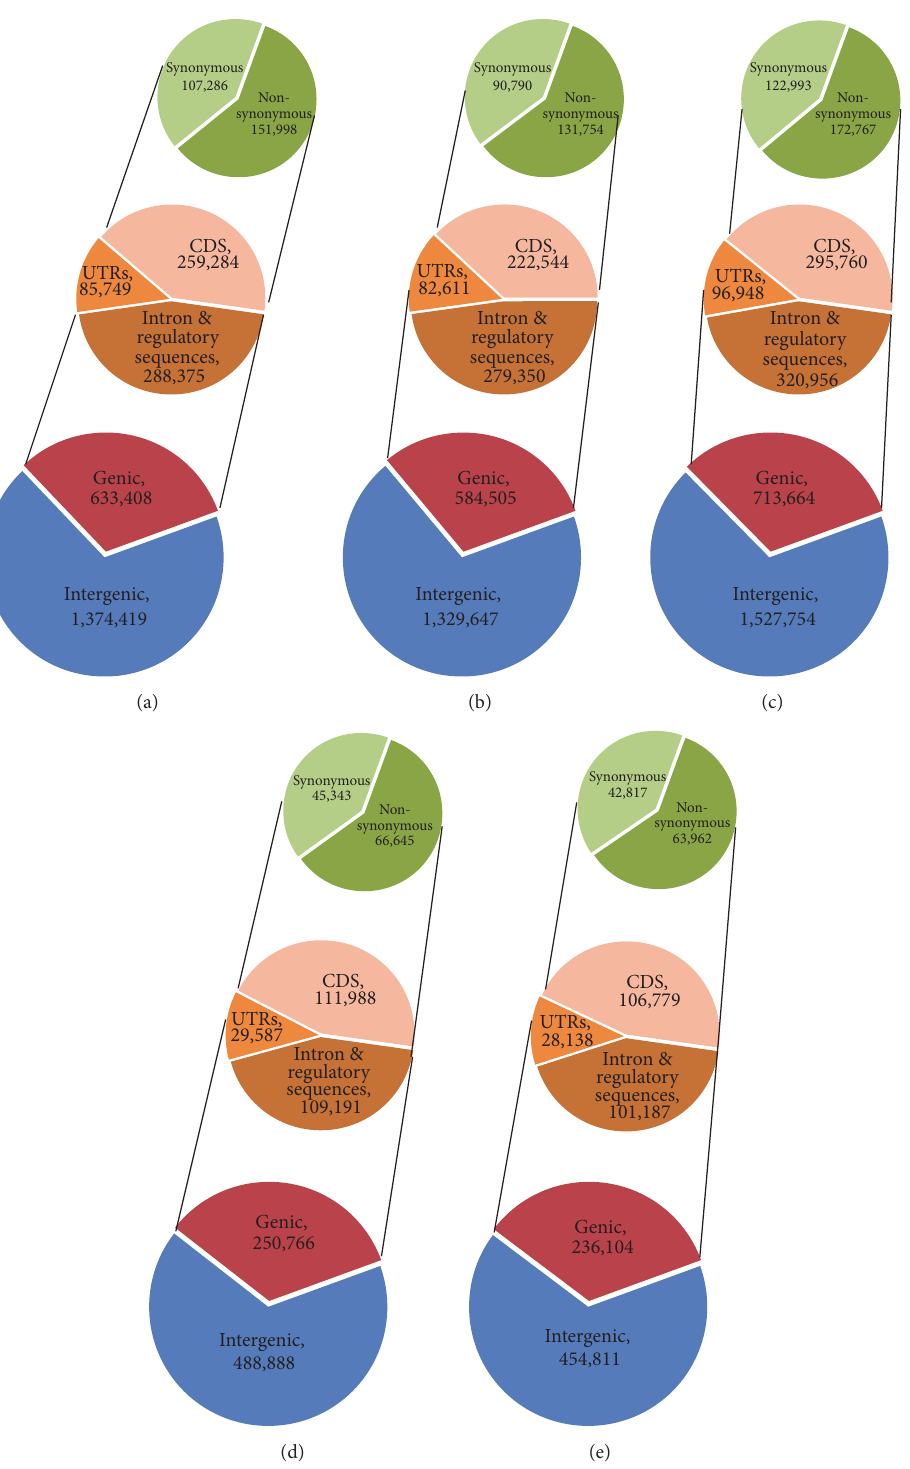
Figure 5: Annotation of single nucleotide polymorphisms (SNPs) between five Vietnamese rice landraces ((a) indica 12, (b) indica 13, (c) indica 15, (d) japonica 11, and (e) japonica 14) and Nipponbare based on the annotations of Nipponbare reference